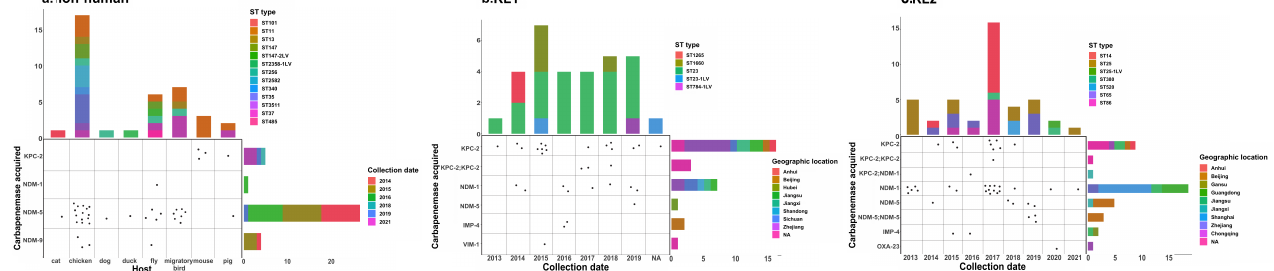
Figure 3. Distribution of carbapenemase-carrying non-human, KL1, and KL2 KPN. ( a ) Carbapenemase-carrying non-human KPN; ( b ) KL1 carbapenemase-carrying KPN; ( c ) KL2 carbapenemase-carrying